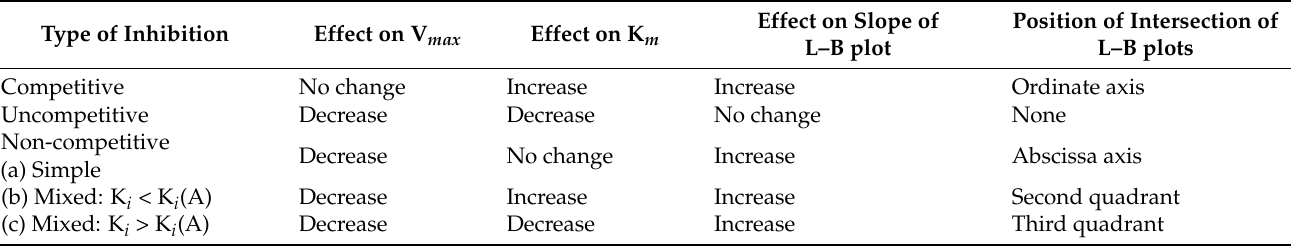
Table 5. Enzyme inhibition patterns